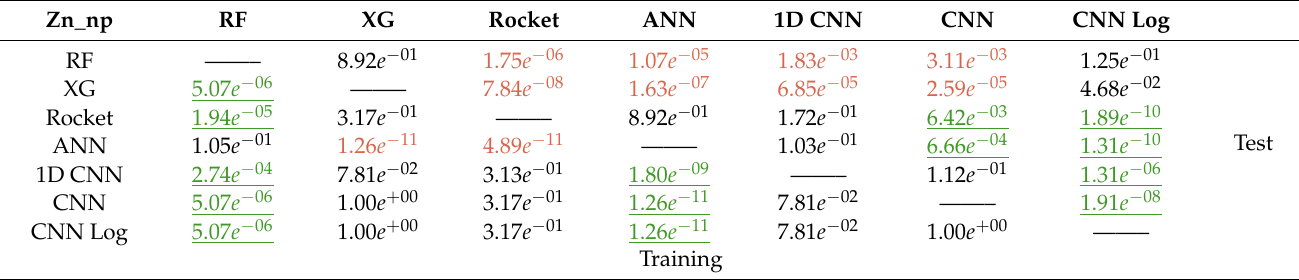
Table A14. Kruskal–Wallis p -values comparing all methods of the zn_np concentration prediction task. Above the diagonal, we have the results for the test set, and below for the training set. Significant results ( p < 0.01) are represented in green or red when the method on the left is significantly better or worse,